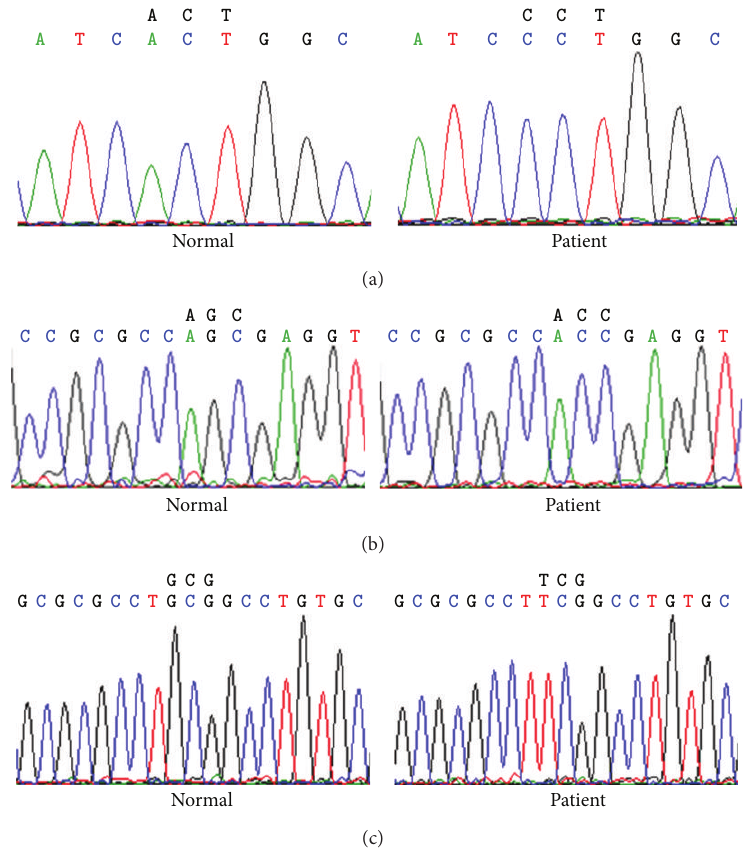
Figure 2: Nucleotide polymorphism in TPO gene study population. (a) Nucleotide polymorphism in patient ID-147, Exon11, and ACT > CCT (Thr > Pro). (b) Nucleotide polymorphism in patient ID-6, Exon7, and AGC > ACC (Ser > Thr). (c) Nucleotide polymorphism in patient ID-183, Exon7, and GCG > TCG (Ala > Ser).